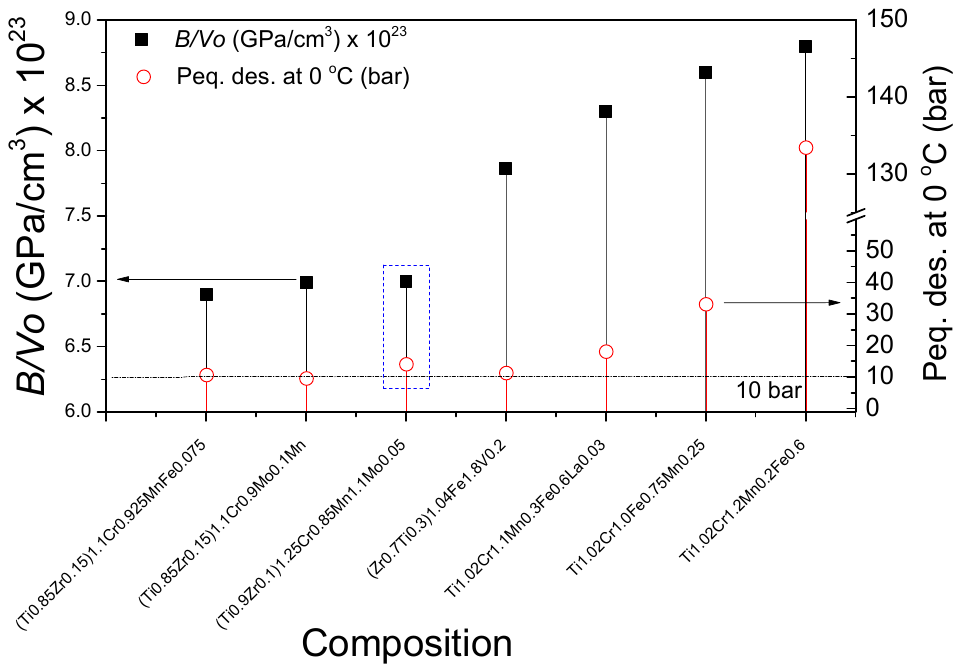
Figure 8. Ratio of bulk modulus and cell volume of the alloys and dehydrogenation equilibrium pressures at 0 °C for the best AB 2 C14 compositions for the hybrid concept and the herein obtained alloy. [18,21,24,27,33,44]